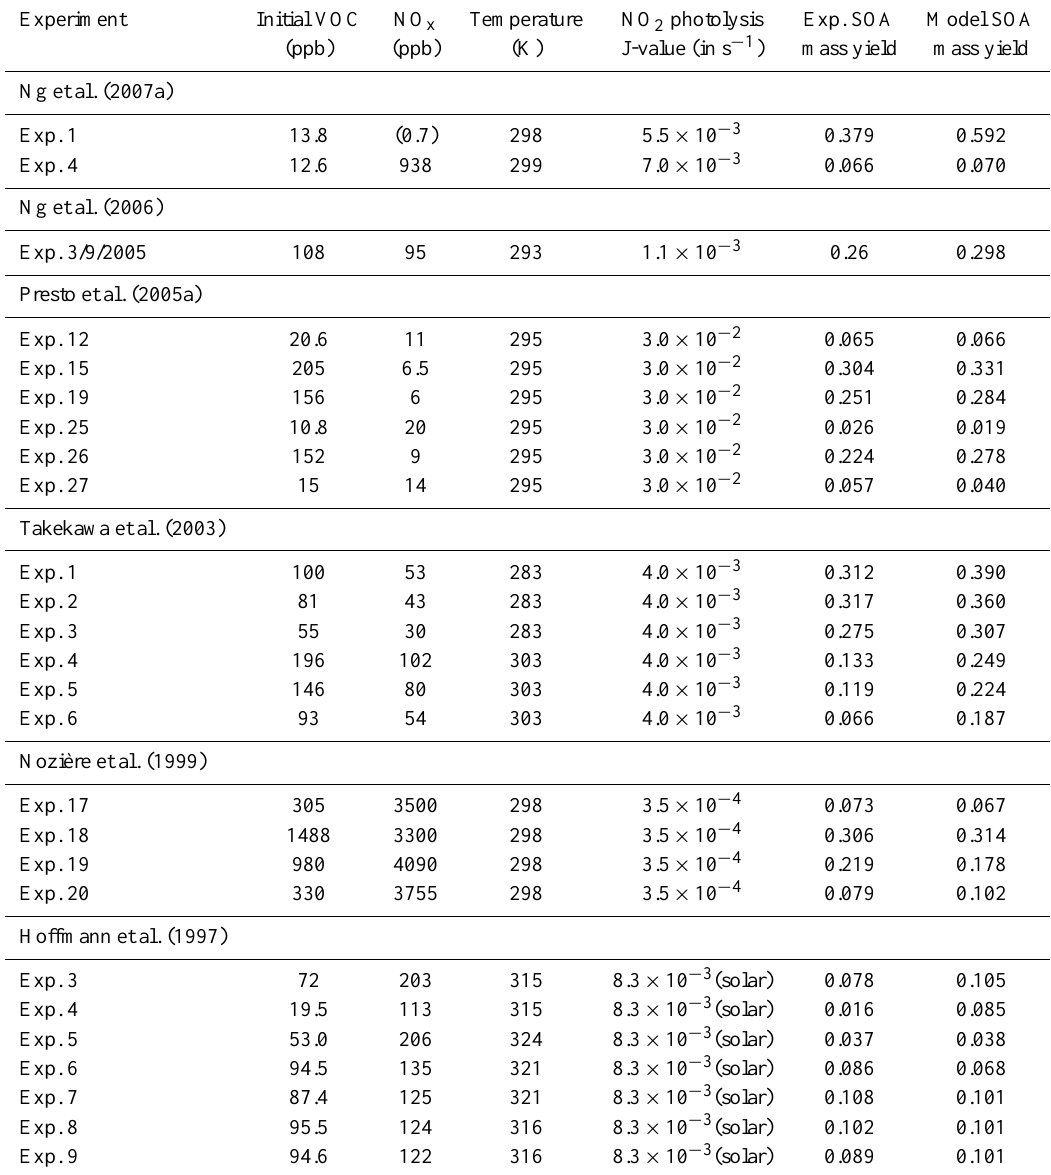
Table 2. Photooxidation smog chamber experiments simulated with the full BOREAM